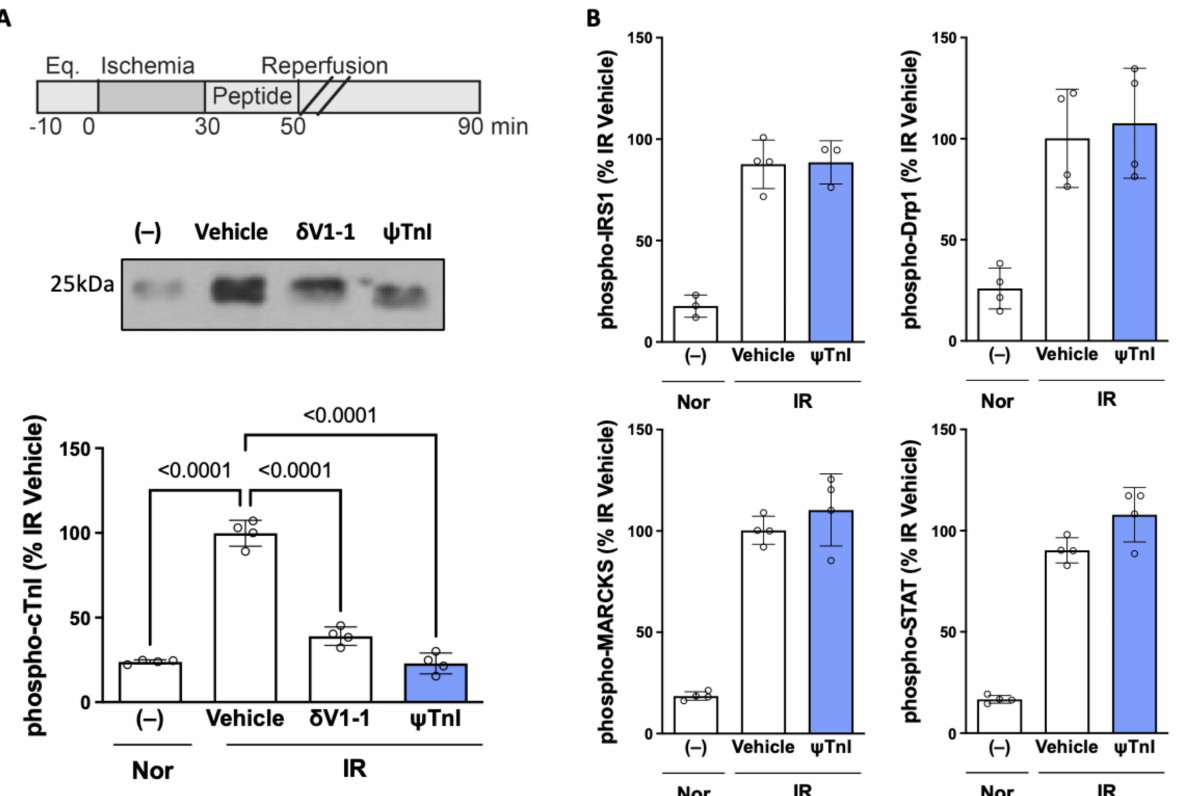
Figure 3. ψ TnI inhibits cTnI phosphorylation by δ PKC. Male rat hearts were subjected to 90 min perfusion (Nor; normoxia) or I 30min R 60min in the presence of a selective pan-inhibitor of δ PKC ( δ V1-1), control (vehicle; TAT), or in the presence of the selective inhibitor of cTnI, ψ TnI. Phosphorylation was determined by Western blots. ψ TnI selectively inhibits δ PKC-mediated cTnI phosphorylation ( A ). ψ TnI does not affect phosphorylation of other δ PKC targets, such as dynamin-related protein 1 (Drp1), signal transducer and activator of transcription (STAT), insulin receptor substrate 1 (IRS1), and myristoylated alanine-rich c-kinase substrate (MARCKS) ( B ); n = 4 biological replicates (open circles) unless otherwise stated; 1 µ M δ V1-1, TAT, or ψ TnI used. Data were evaluated by one-way ANOVA with Tukey’s multiple comparisons between each treatment group and p <